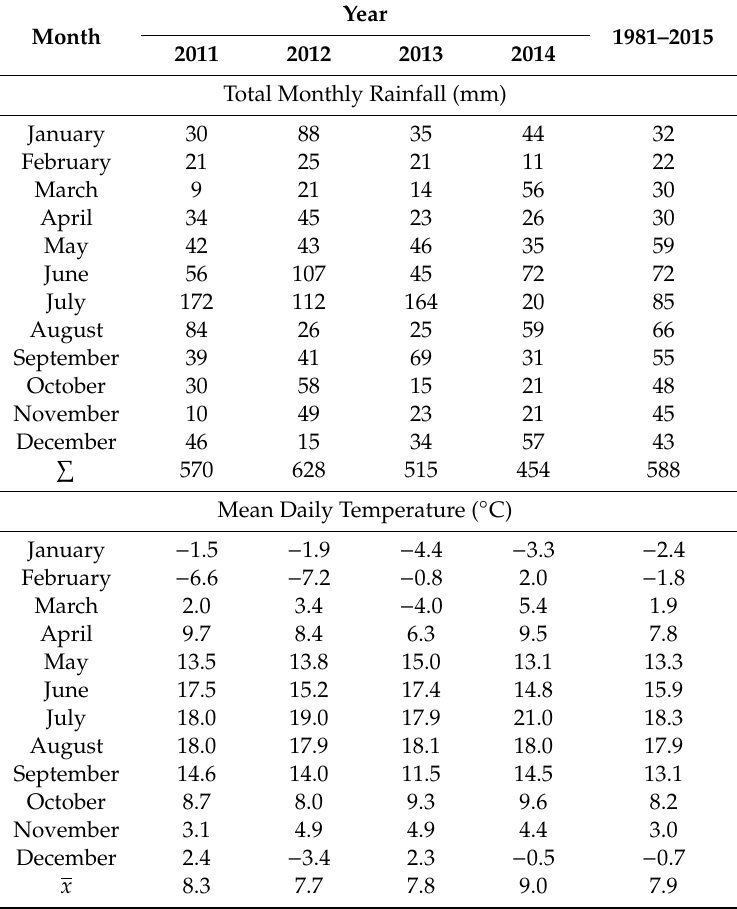
Table 4. Weather conditions during the experiment (2011–2014) vs. the long-term average (1981–2015) in the Agricultural Experiment Station in Bałcyny, Poland (53 ◦ 35 (cid:48) 46.4” N, 19 ◦ 51 (cid:48) 19.5” E). Adapted from